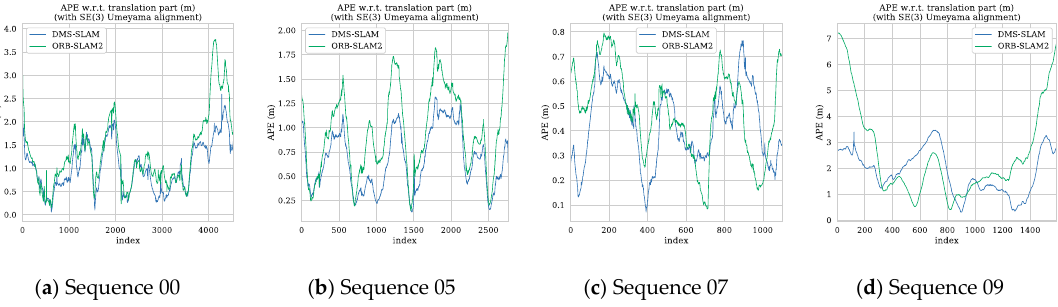
Figure 16. ( a – d ) In the sequence of KITTI dataset 00, 05, 07, 09, we use SE (3) to align the motion trajectory with the Ground Truth, and obtain the APE distribution of ORB-SLAM2 and DMS-SLAM.